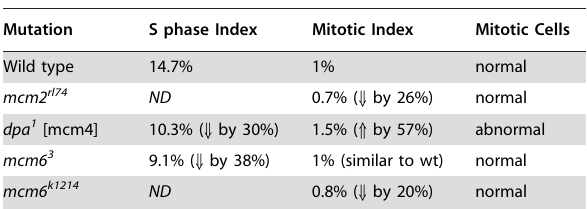
Table 1. Quantitation of cell cycle parameters of Drosophila